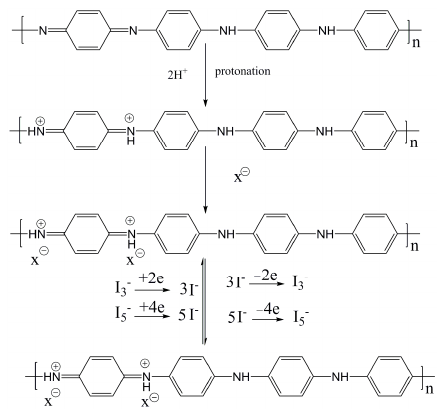
Figure 7. Schematic diagram of oxidation-reduction reactions among iodine with different valence. The x represents I − , I 3 − , I 5 − , SO 42 − , etc.